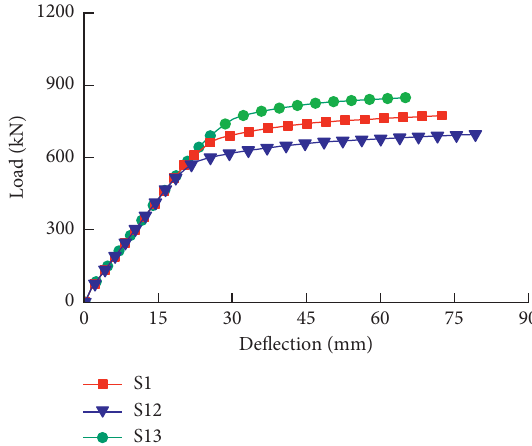
Figure 9: Load vs. midspan deflection with different yield strengths of steel tubes.